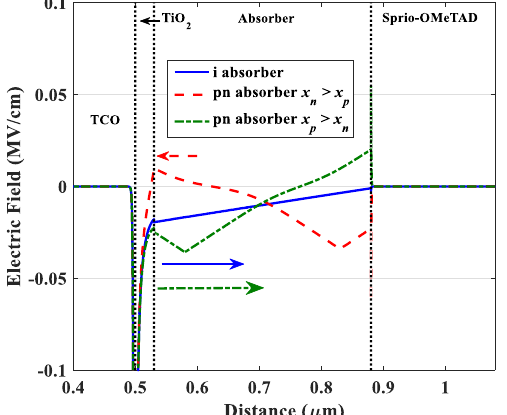
Figure 7. Electric field distribution across the device distance for the three cases of absorbers. The field is calculated at a voltage of 0.5 V. The electric field direction is also indicated in the figure by arrows.